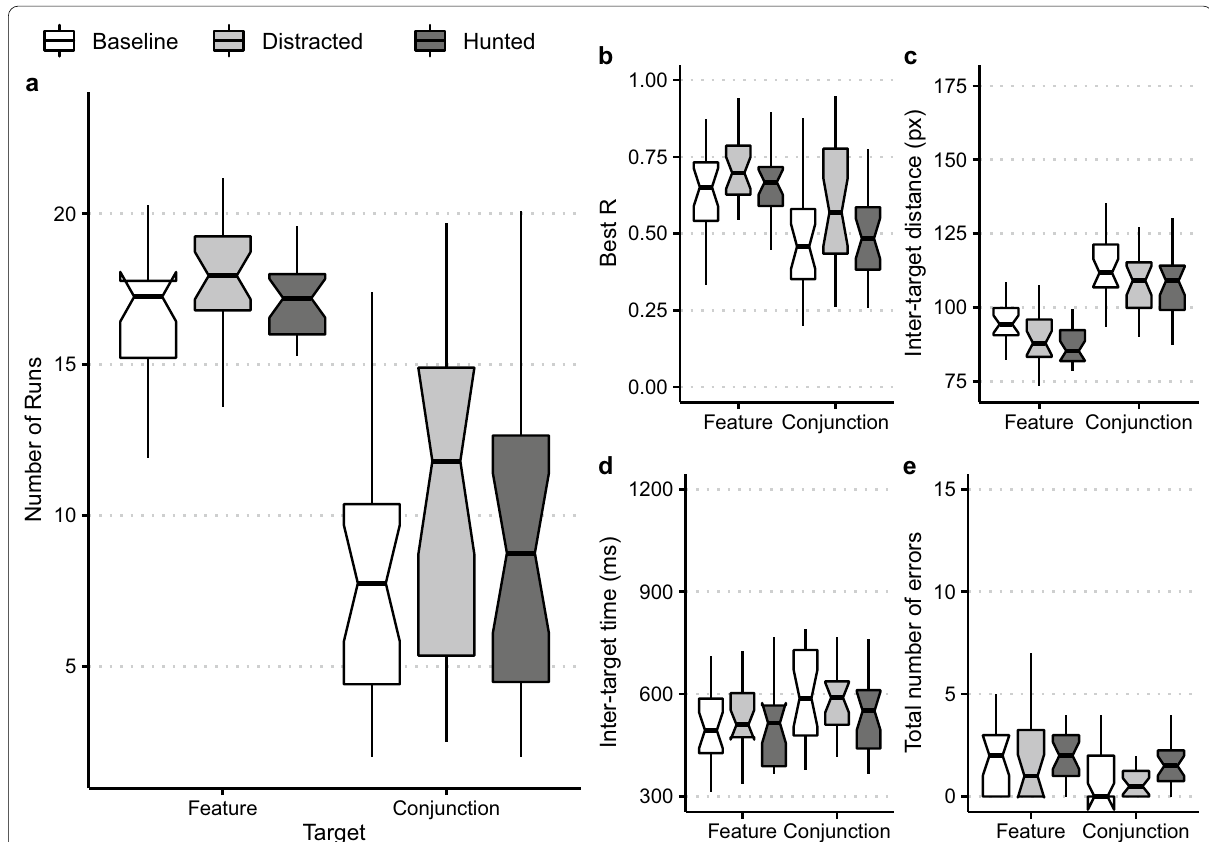
Fig. 7 The interaction between Predation (Distracted/Hunted) and Target (Feature/Conjunction) in Experiment 2. Horizontal lines show the central tendency (median) of each distribution, with notches indicating 95% confindence intervals. Boxes identify the upper (75%) and lower (25%) quartiles, with the whiskers indicating maximum and minimum